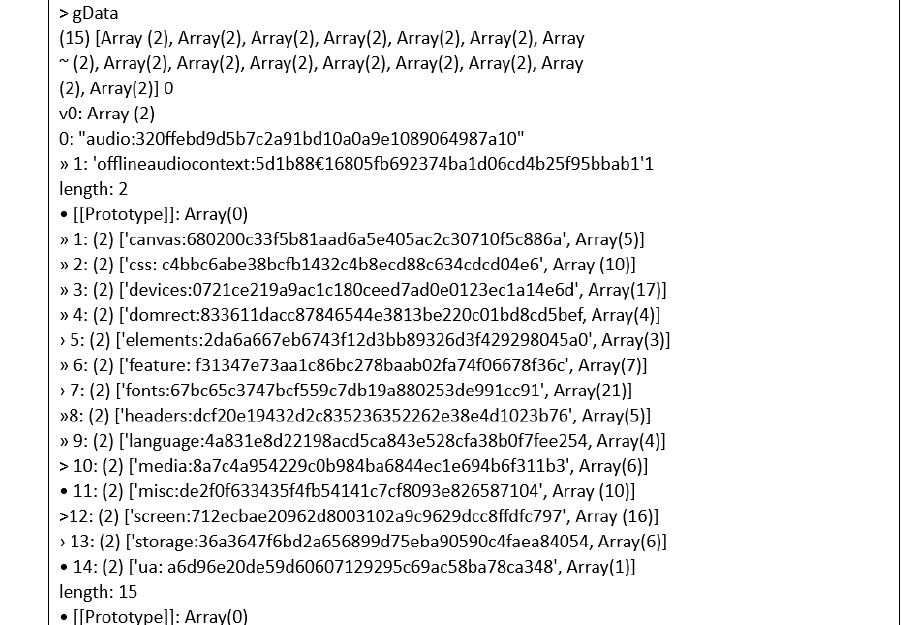
Figure 6. Example of attribute array values in the console log of the website.